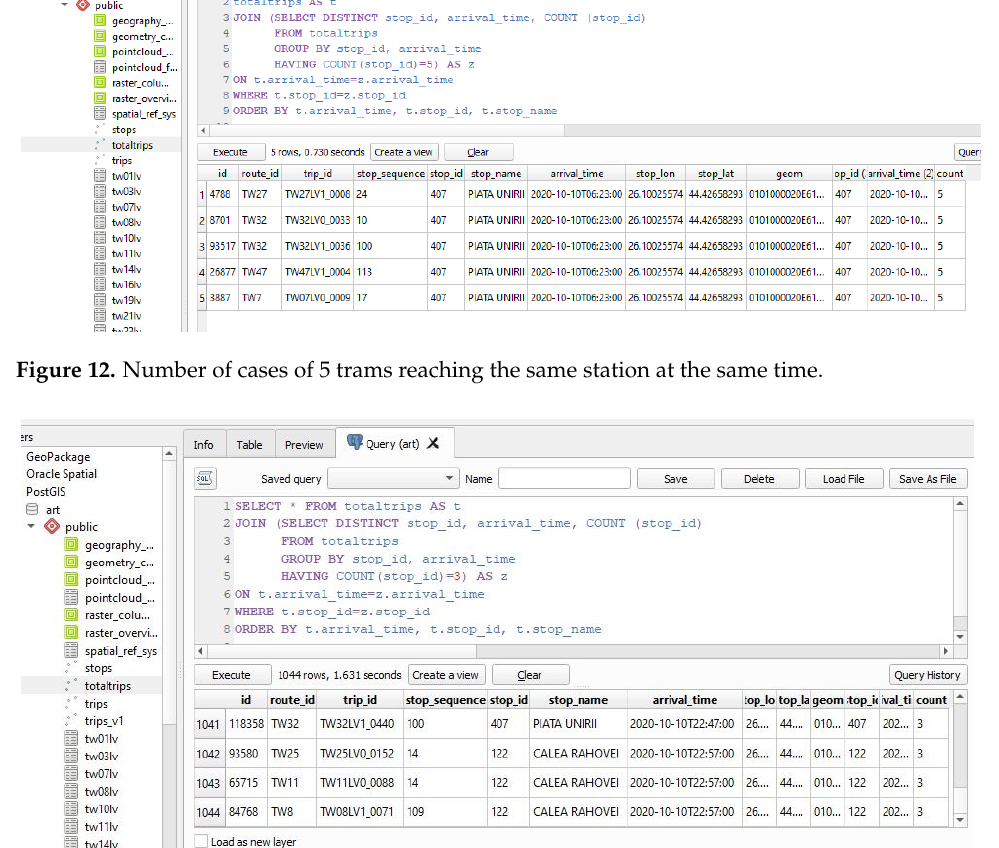
Figure 12. Number of cases of 5 trams reaching the same station at the same time.